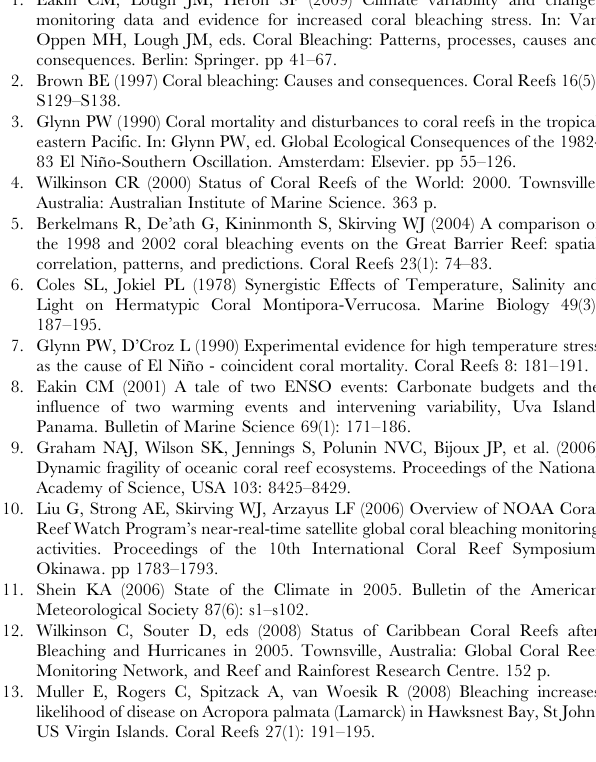
Figure S4 Comparison of bleaching survey methods. All observations of percent coral colonies (gray circles) and cover (black diamonds) are plotted versus observed Degree Heating Week (DHW). Linear regressions for colonies (gray line) and cover (black line) were highly significant (cover slope = 3.91, intercept = 19.99, df = 212, p , 0.0001, r 2 = 0.26; colonies slope =3.43, intercept = 29.46, df = 304, p , 0.0001, r 2 =0.24) and indicated no difference in slopes, suggesting comparable results. Found at: doi:10.1371/journal.pone.0013969.s004 (0.08 MB TIF) Table S1 Complete data record for all survey data used in the analyses. Multiple observations from the same reef site, date and depth ( 6 5 m) were combined as either means of percent cover data or proportion of the number of colonies surveyed to provide 2575 bleaching surveys and 1077 mortality